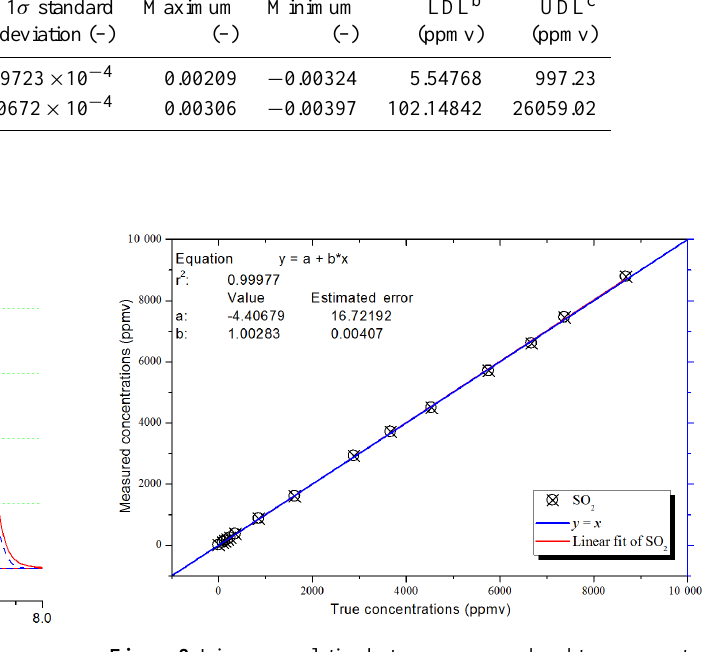
Figure 7. Transmissions of the filters in Table 1. The red solid lines are actual transmission functions and the blue dotted lines are cor- responding Gaussian functions assumed in Sect. 3.